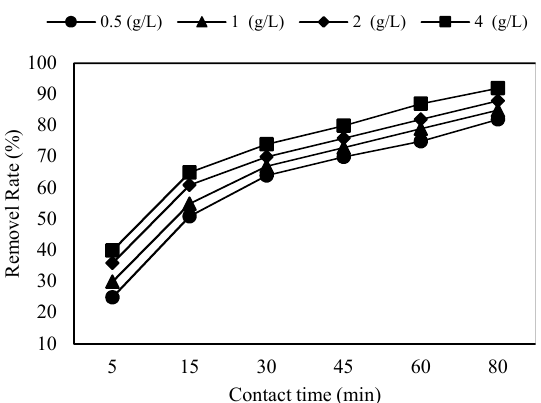
Fig. 7. Effect of adsorbent dosage on the sorption